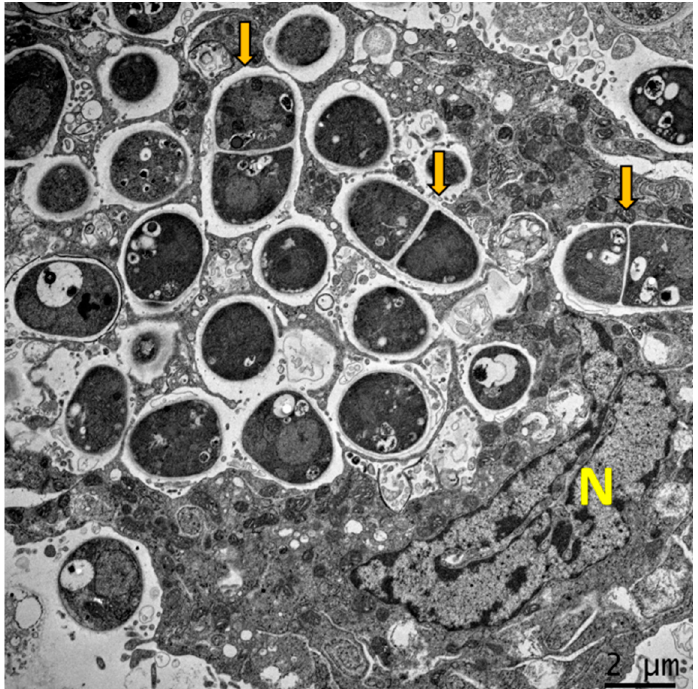
Figure 1. Dimorphism of T. marneffei inside macrophage. The major virulence factor of T. marneffei is dimorphic switching. Transmission electron microscopy (TEM) of a THP - 1 human macrophage infected with T. marneffei demonstrates that T. marneffei conidia undergo morphogenesis to fission yeast (depict by yellow arrows) inside the phagosome by 24 h after internalization. The photograph was taken under 3000× magnification with a JEM - 2200FS (Japan) microscope. N represents the THP - 1 nucleus.